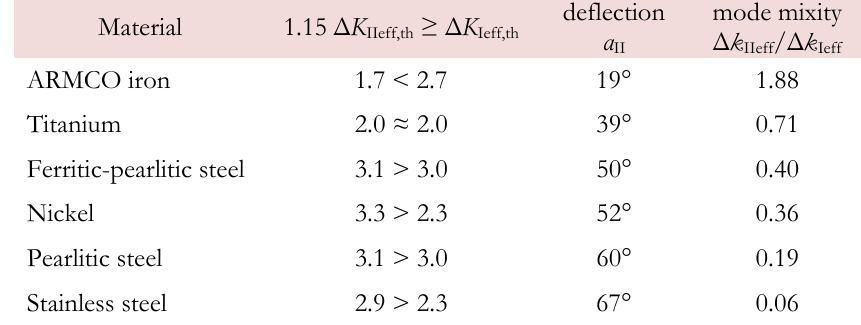
Table 2: Fulfillment of the mode I branching criterion and comparison with the real tendency to mode I crack growth measured on fracture surfaces of the six tested materials in terms of deflection angles α II and local mode mixities according to Eq. (4).